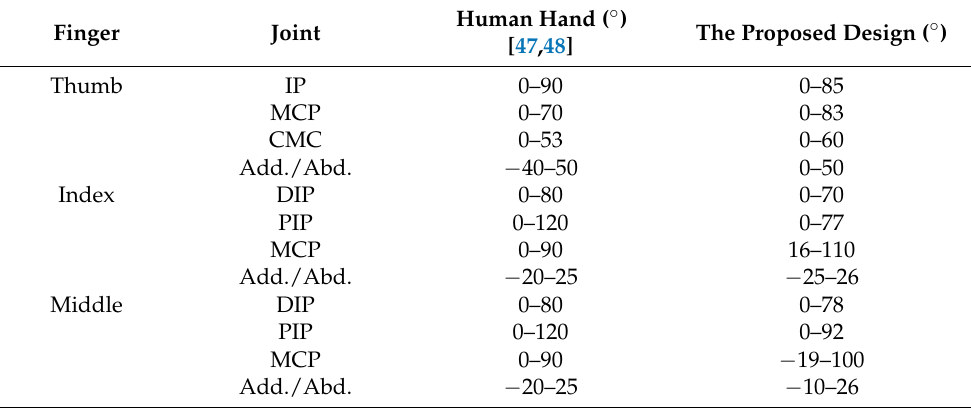
Table 3. Comparison of the range of motion.